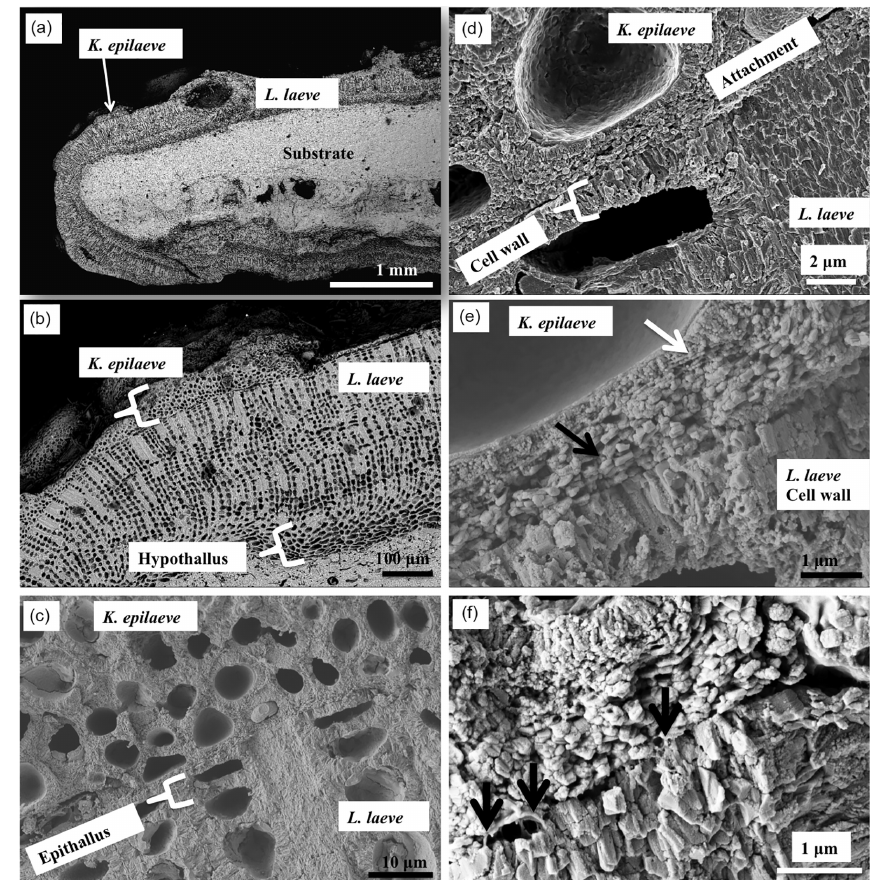
Figure 2. Overview of K. epilaeve on L. laeve . (a) Overview (BSE). L. laeve has been partly overgrown by K. epilaeve . (b) Closer up (BSE), K. epilaeve has a very thin perithallium with thicker buildup for its conceptacle. (c) Close up (SE) and (d) showing attachment zone of K. epilaeve hypothallus on the epithallus of the L. laeve . (e) (SE) The cell wall in the L. laeve is roughly radial whereas the K. epilaeve cell wall does not appear properly mineralised with nanometre-scale beads of Mg-calcite along what appears to be organic fibrils (white arrow). The K. epilaeve Mg-calcite layer at the attachment zone has coarse angular grains roughly parallel to the L. laeve surface (black arrow). (f) (SE) Organic fibrils are visible (black arrows) between the base of the K. epilaeve and the surface of the L. laeve , suggesting this is the attachment